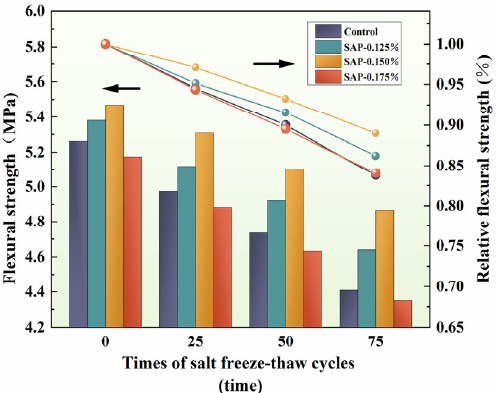
Figure 5. Variation of flexural strength and relative flexural strength with salt freeze–thaw cycles times.